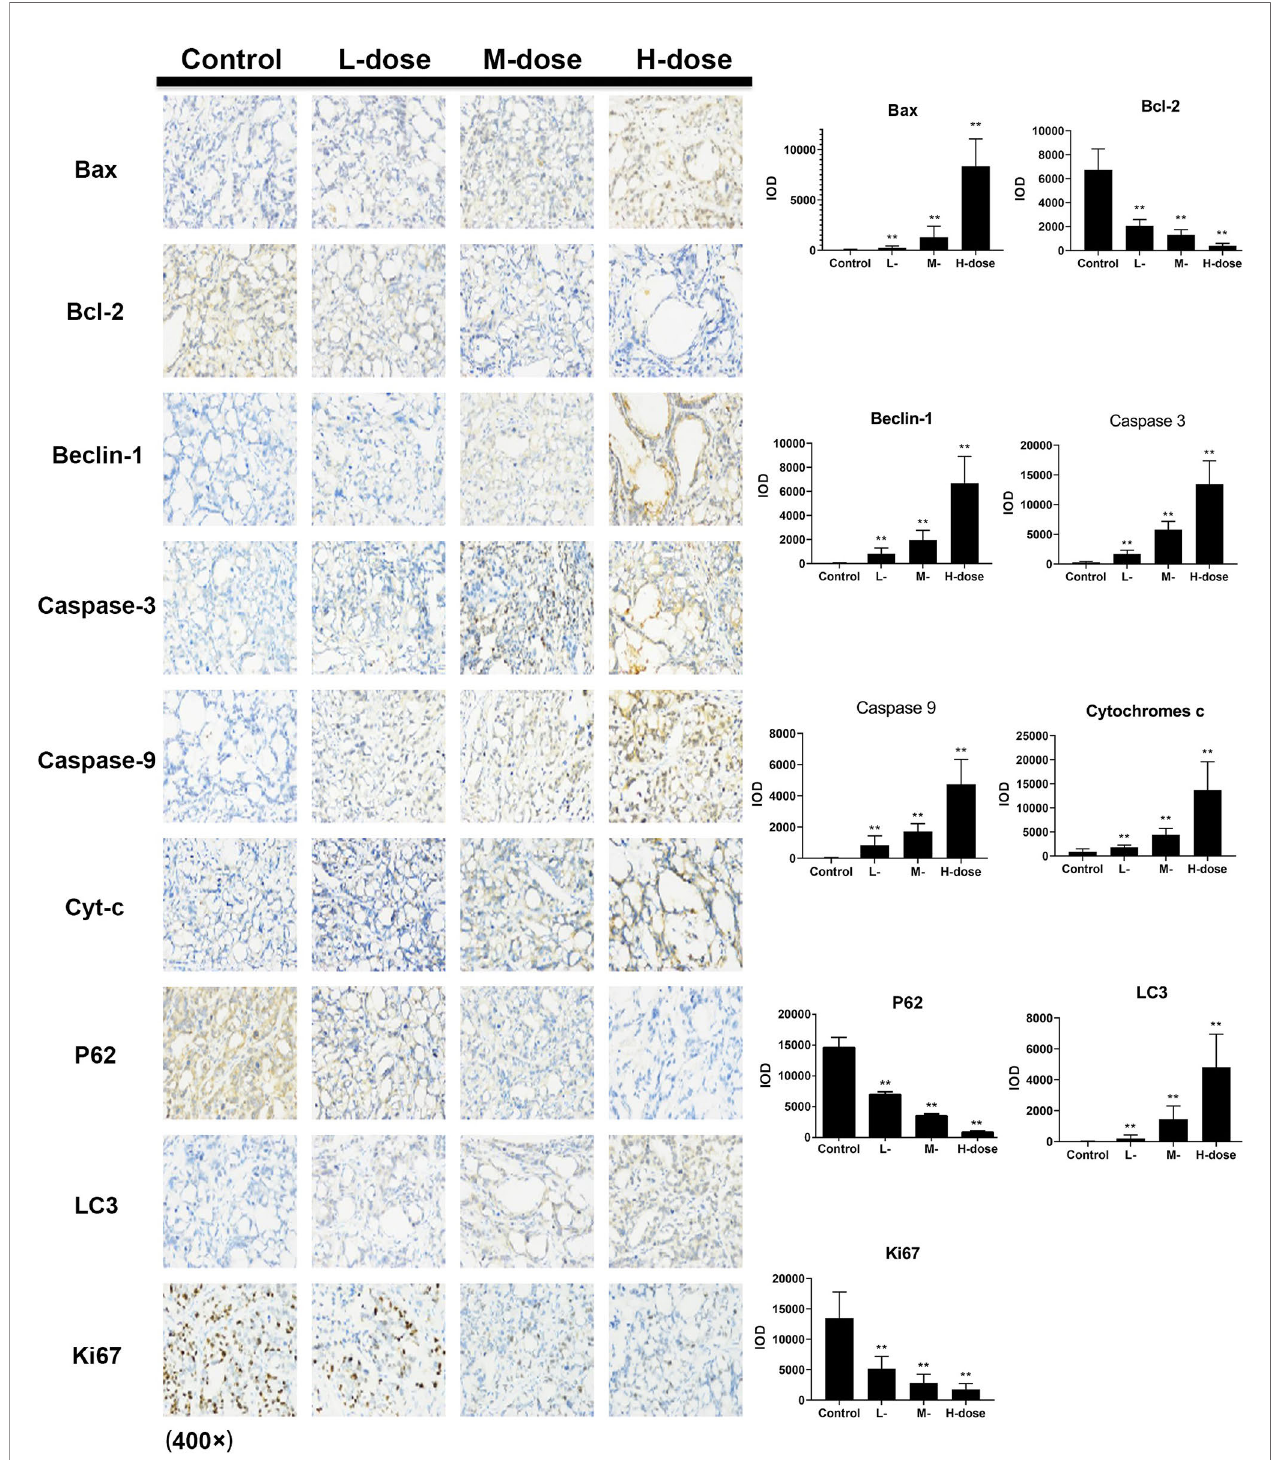
FIGURE 8 | Effect of SDEA on the expression levels of apoptosis- and autophagy-related genes in the issue from HT29 xenografts (control, po., N.S.; low dose, po., 00 mk/kg/day; medium dose, po., 200 mg/kg/day; and high dose, po., 300 mg/kg/day). (* p < 0.05; ** p < 0.01, vs. control group).